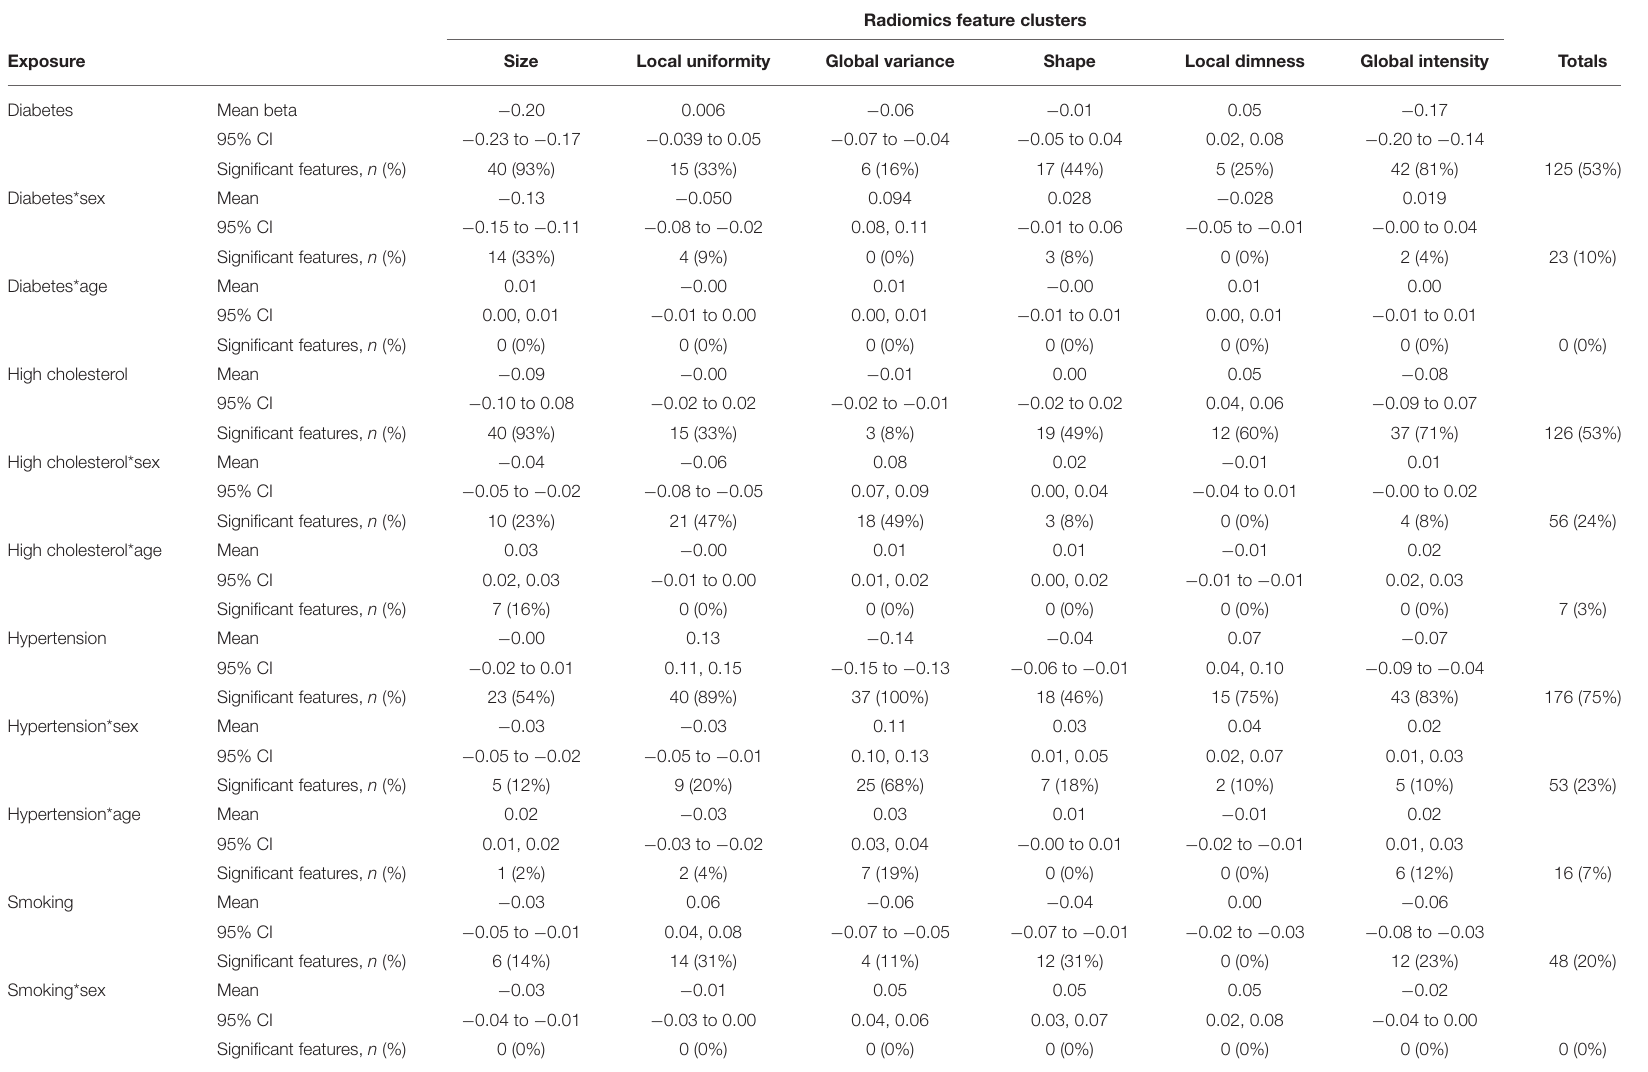
TABLE 4 | Relationship of vascular risk factors with radiomics features in the healthy subset expressed as the average association within each of the six radiomics feature